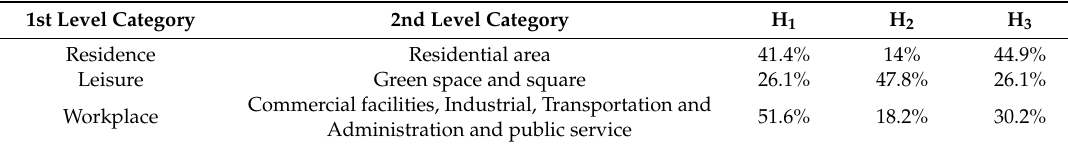
Table 4. Spatial semantics of H 1 , H 2 , and H 3 based on POI categories.